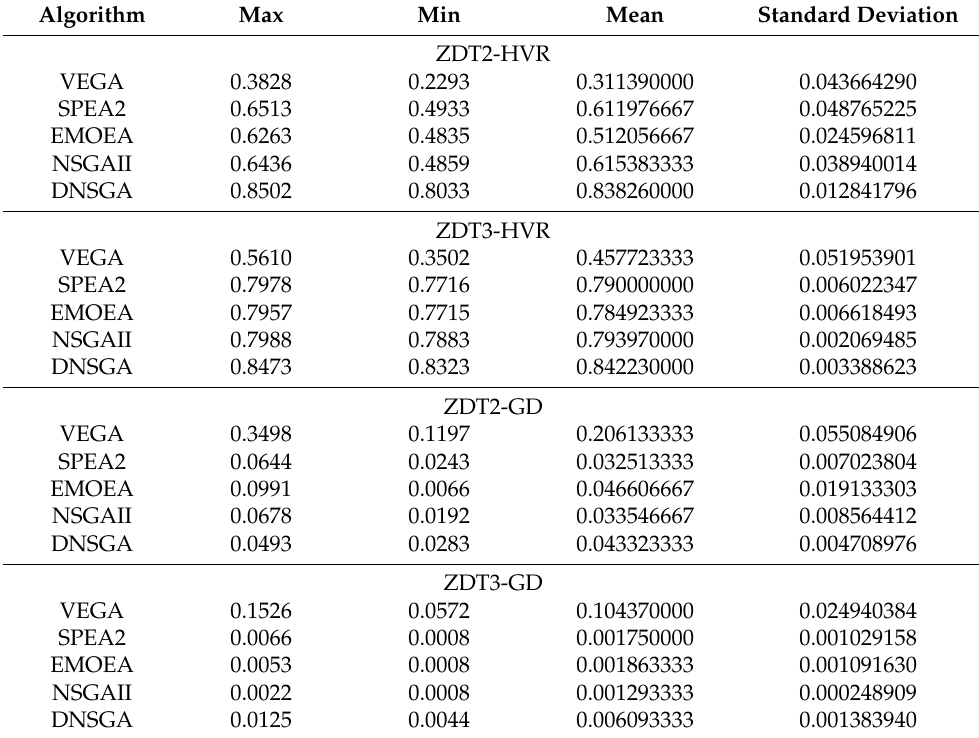
Table 2. Statistical results of different classical multi-objective evolutionary